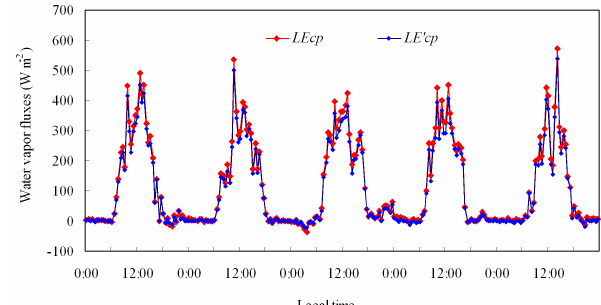
Figure 4. Comparison of water vapor fluxes calculated with a fixed lag time and time lags estimated from the optimized covariance maximum method during the observation period (17–21 August